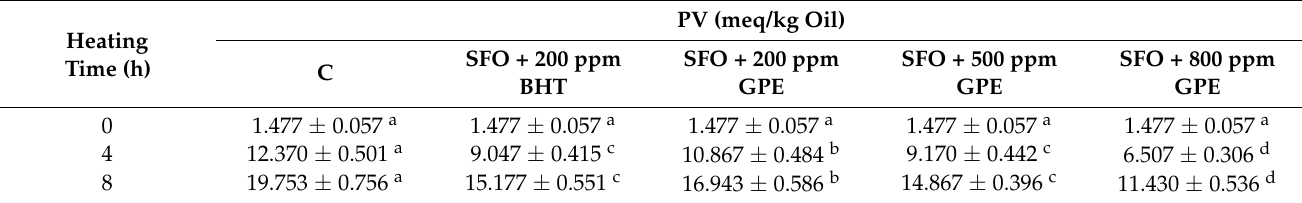
Table 3. Changes in peroxide values (PV) of sunflower oil (SFO) samples with the addition of GPE and BHT during convective heat exposure, compared to the control sample